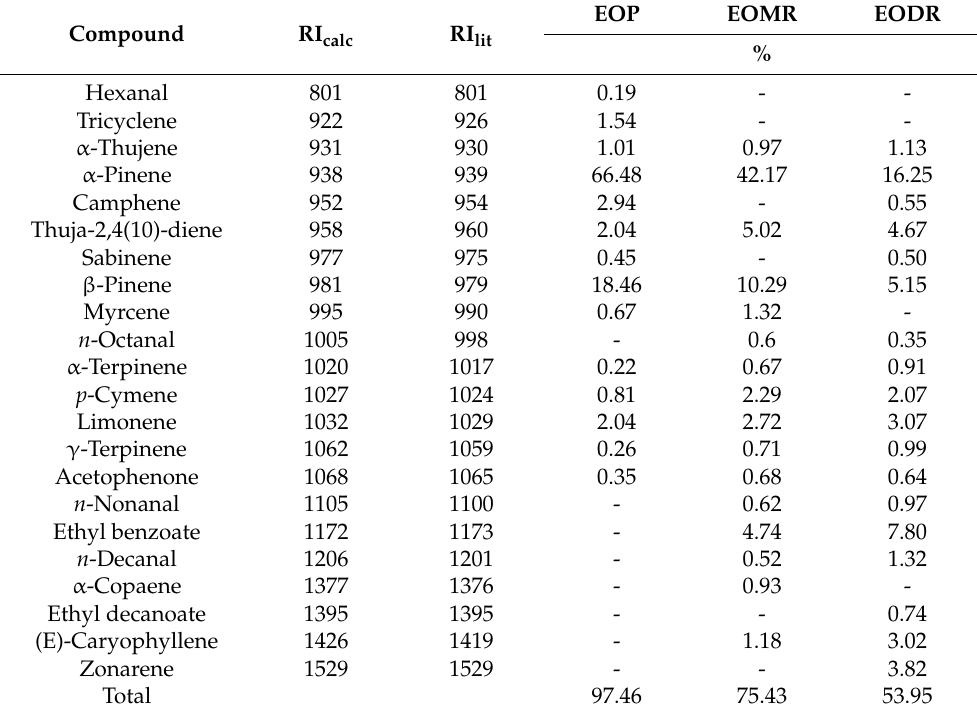
Table 1. Chemical composition (%) of the essential oils extracted from crude organic propolis and from its moist and dry residues.